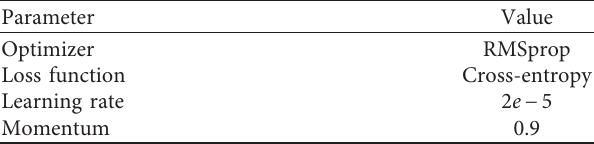
Table 2: CNN training hyperparameters. Table 3: Test results obtained with different CNNs architectures.